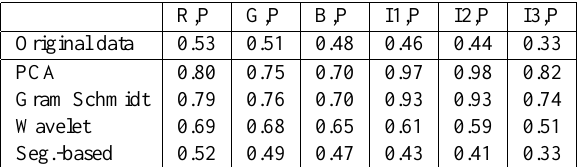
Table 2: Correlation coefficients between the panchromatic im- age and different bands of the original and the pansharpened